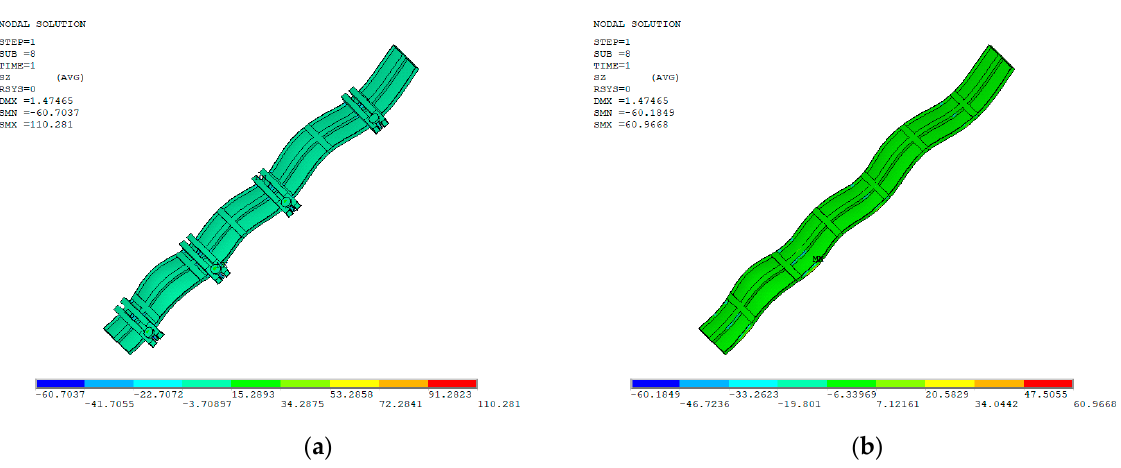
Figure 13. Stress nephogram along Z -direction: ( a ) outside view; ( b ) inside view.